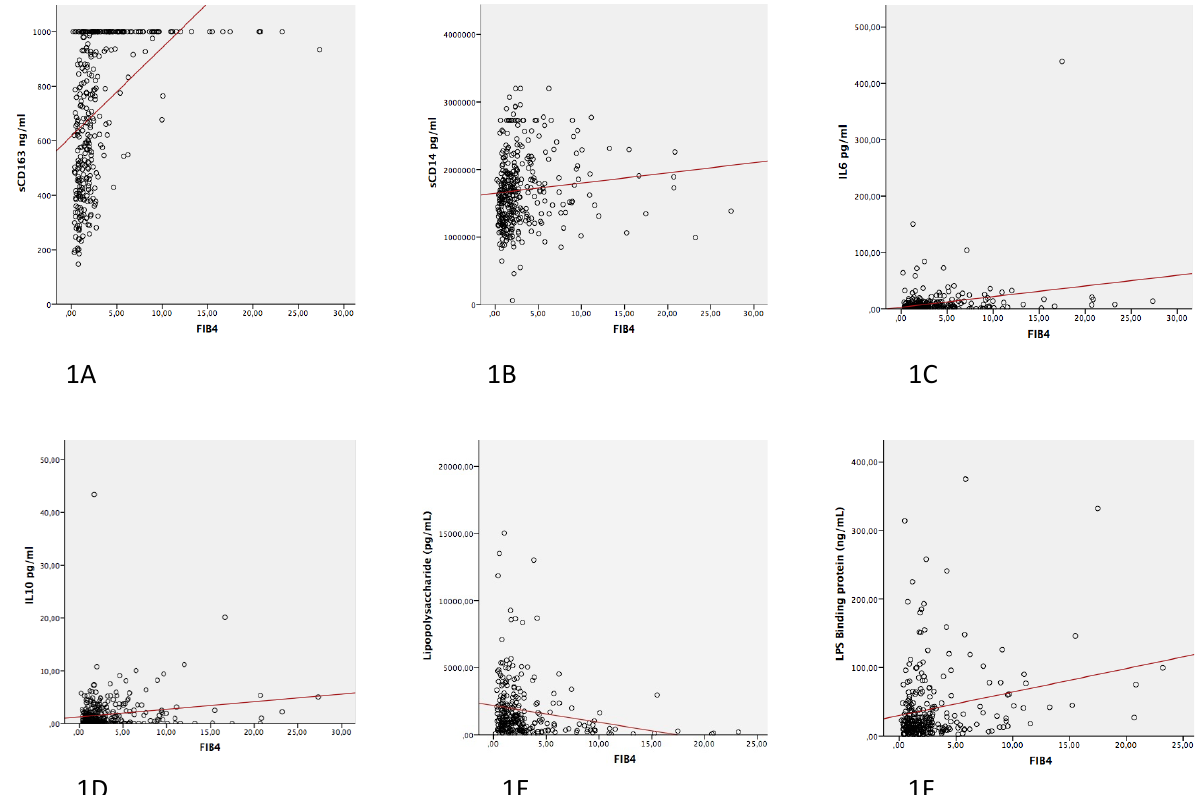
Figure 1. Unadjusted correlation plots between the different markers and FIB-4 levels: ( 1A ) sCD163; ( 1B ) sCD14; ( 1C ) IL-6; ( 1D ) IL-10; ( 1E ) LPS; and ( 1F ) LBP.